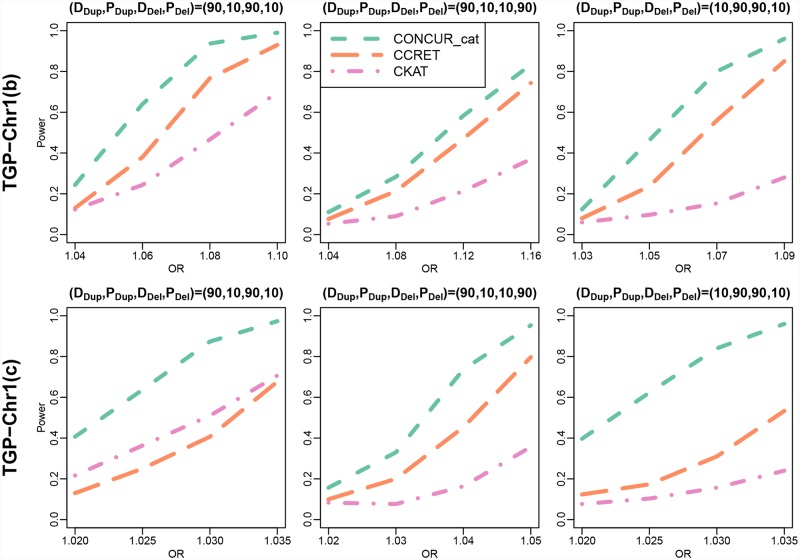
Power comparison between CONCUR, CCRET, and CKAT in TGP-Chr1(b) and TGP-Chr1(c) (causal dosage × length effects from both duplications and deletions in chromosome 1 of TGP data).The top panel shows power under TGP-Chr1(b), in which the kernels are built on CNV data with error added to the CNV endpoints, mimicking the scenario of inaccuracy end points of called CNVs. The bottom panel shows power under TGP-Chr1(c), in which the disease base rate is more rare (5%). Different proportions of deleterious vs. protective effects are considered as indicated by (DDup,PDup,DDel,PDel) with DDup and PDup reflecting the proportions of deleterious and protective segments among causal duplication segments, and with DDel and PDel defined similarly for causal deletion segments.